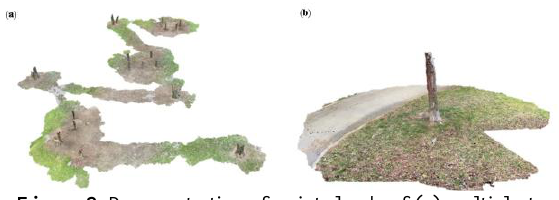
Figure 2. Demonstration of point clouds of (a) multiple-tree mode with 15 mm resolution and low confidence, and (b) single-tree mode with 20 mm resolution and low confidence.